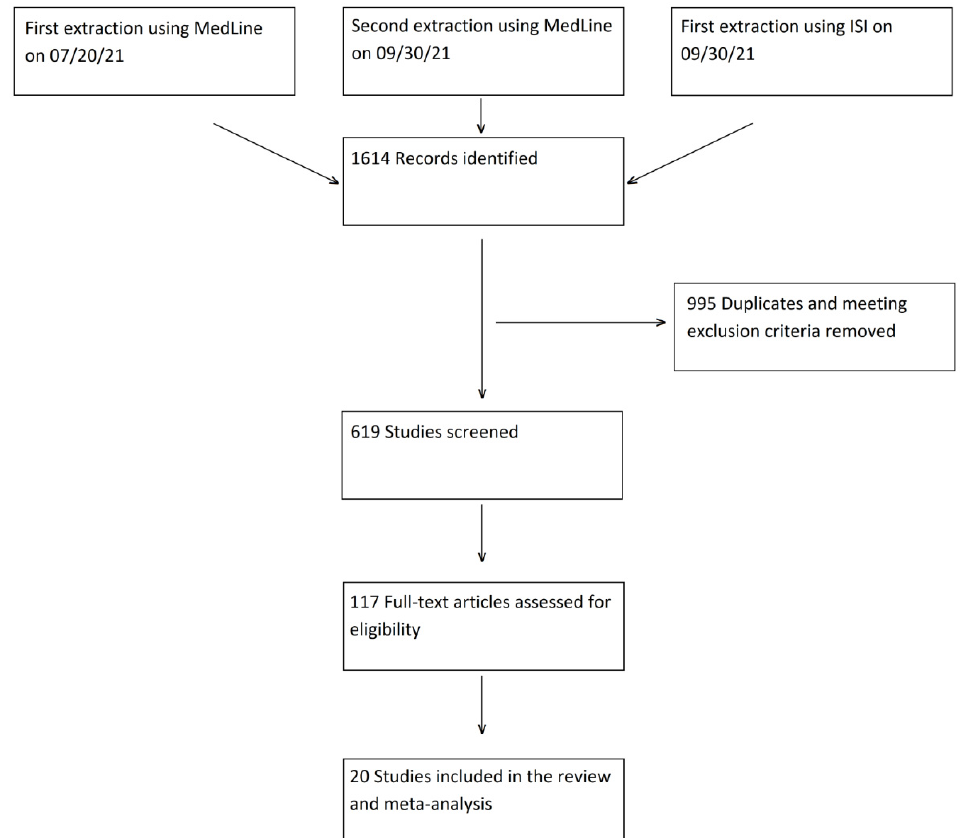
Figure 1. Flow diagram.